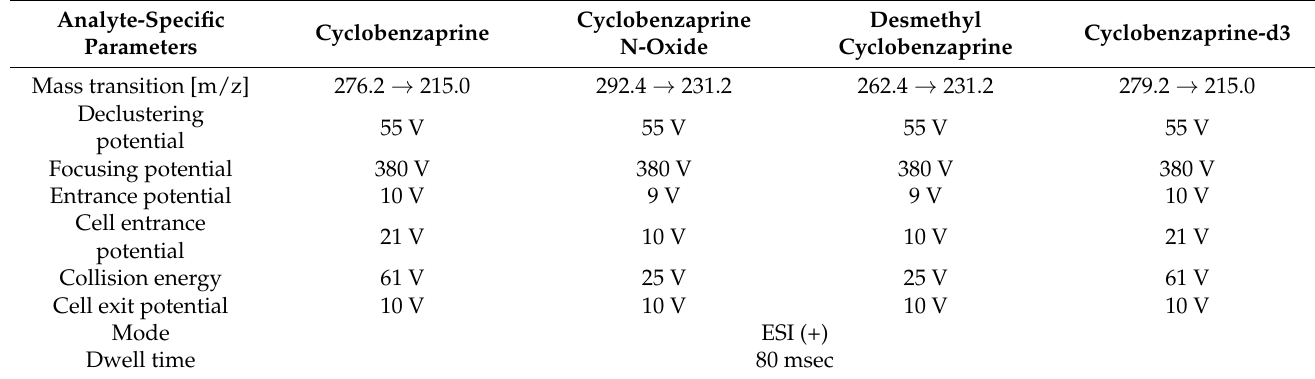
Table 1. Mass spectrometric conditions for cyclobenzaprine, desmethyl cyclobenzaprine and cyclobenzaprine N-oxide. ESI: electrospray ionization, m/z: mass-to-charge ratio, msec: millisecond.